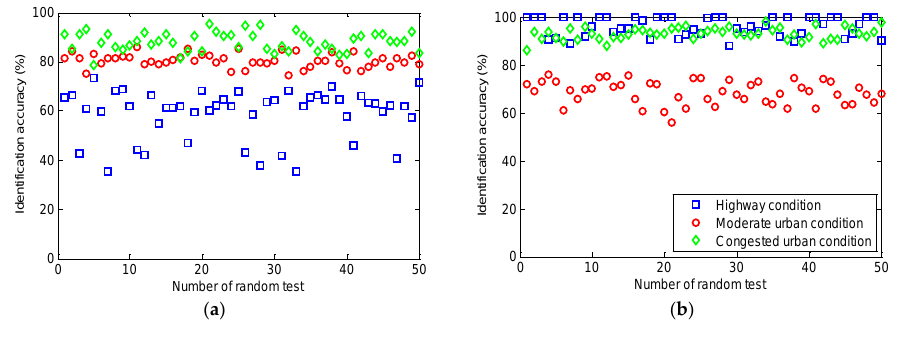
Figure 11. Identification accuracy based on sole characteristic parameter.